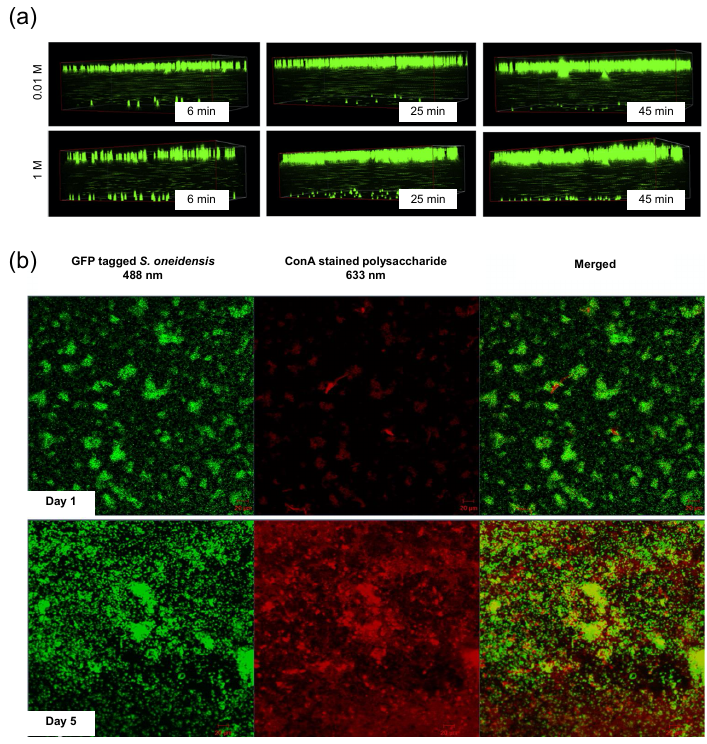
Figure 14. ( a ) Three-dimensional CLSM images of the microfluidic filtration device developed by Di et al. at different filtration times. Experiments were performed at two different KCl concentrations to account for the effects of ionic strength on the fouling process. Channel depth 25 ± 2 µ m. ( b ) CLSM images of multiple stained samples: GFP-tagged S. oneidensis cells (green) and ConA-stained extracellular polysaccharides (red) on a FO membrane after 1 and 5 days of processing. Adapted from [159,160] .